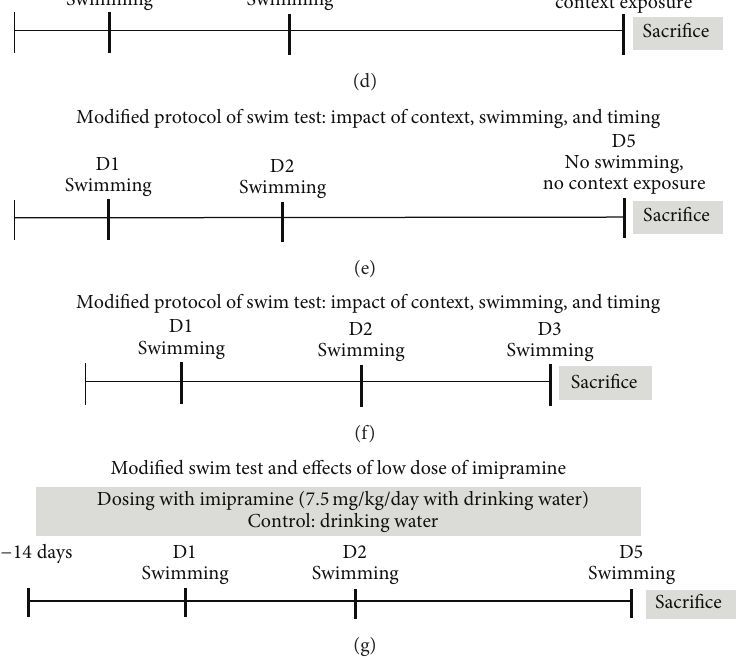
Figure 1: Schematic timeline of experiments. (a) Investigation of behavioural and molecular changes in the modified versus classical swimming paradigms. (b–f) Studies to address the impact of context, swimming, and timing of testing in behavioural and molecular changes induced in the modified swim test. (g) Investigation of behavioural and molecular effects of imipramine in the modified swim test. D1: Day 1; D2: Day 2; D3: Day 3; D5: Day